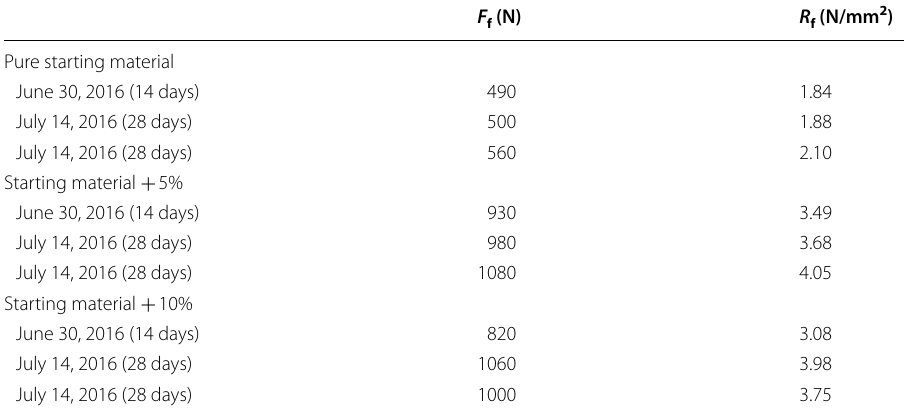
F f indicates the load applied at the center of the sample at the fracture point. Dates indicate times between preparation and realization of the mechanical tests (at 14 and 28 days)